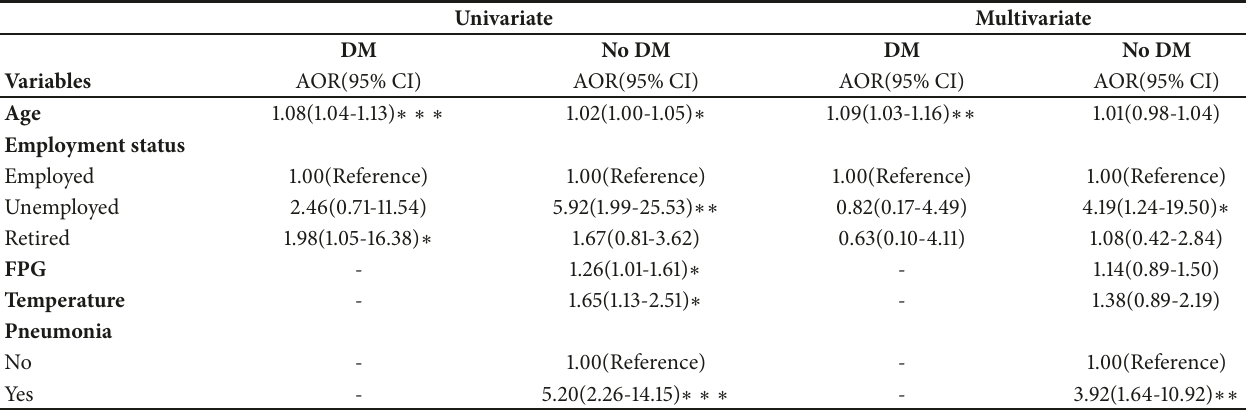
Table 3: Factors associated with functional outcome at 1 month for stroke patients with and without diabetes on univariate and multivariate logistic regression analysis.